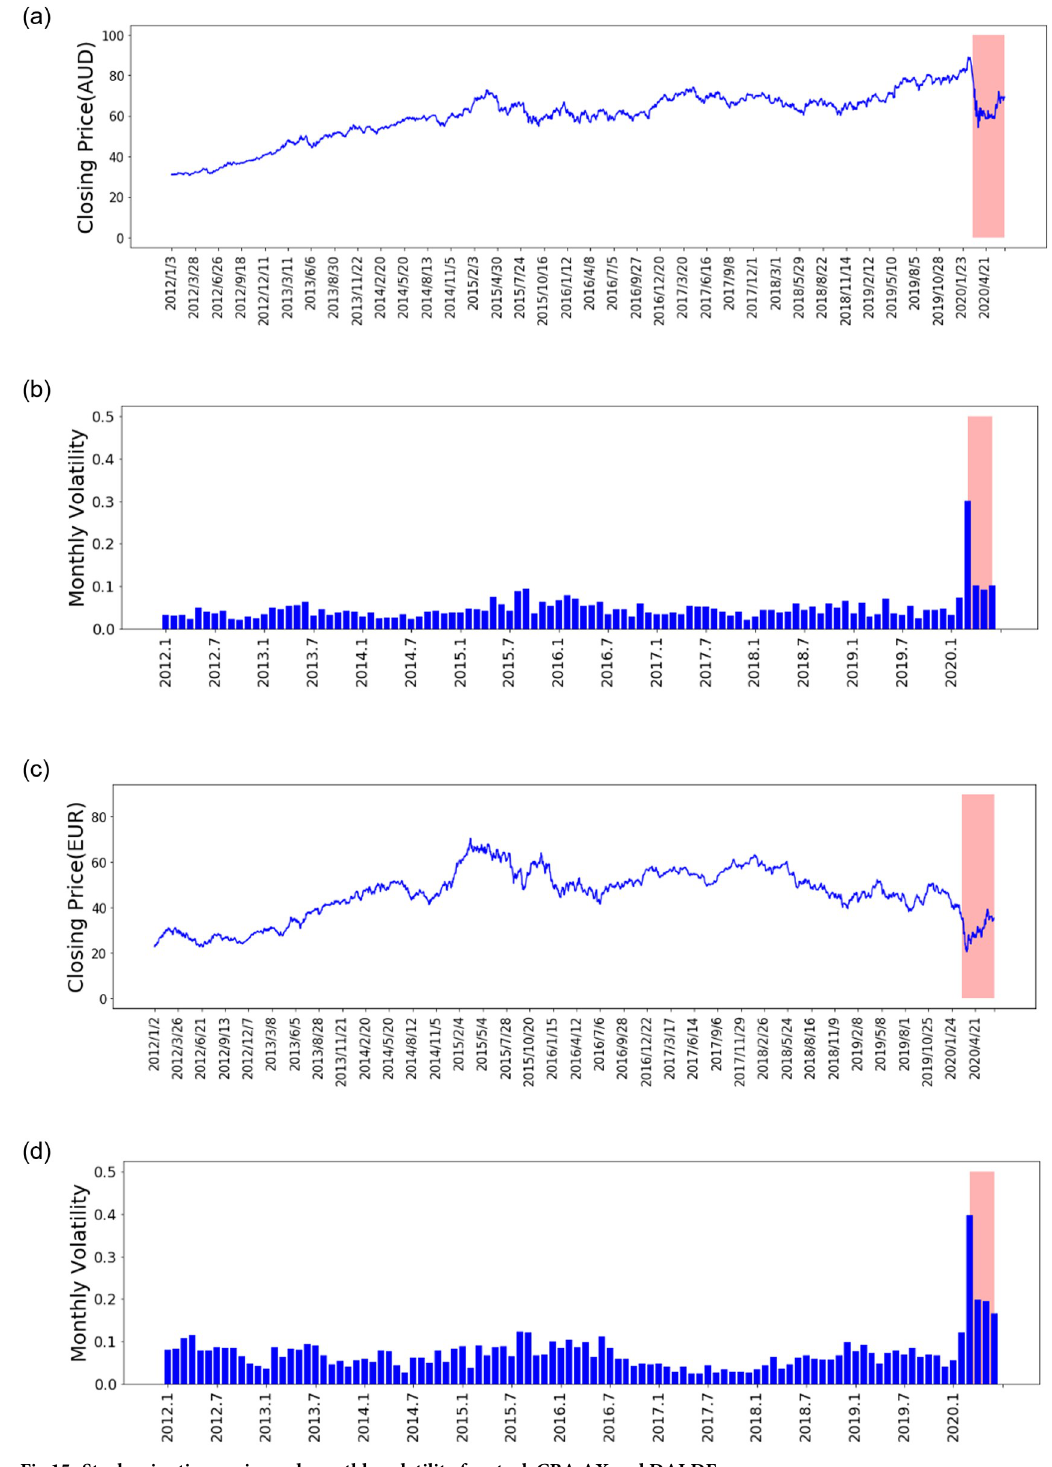
Fig 15. Stock price time series and monthly volatility for stock CBA.AX and DAI.DE.